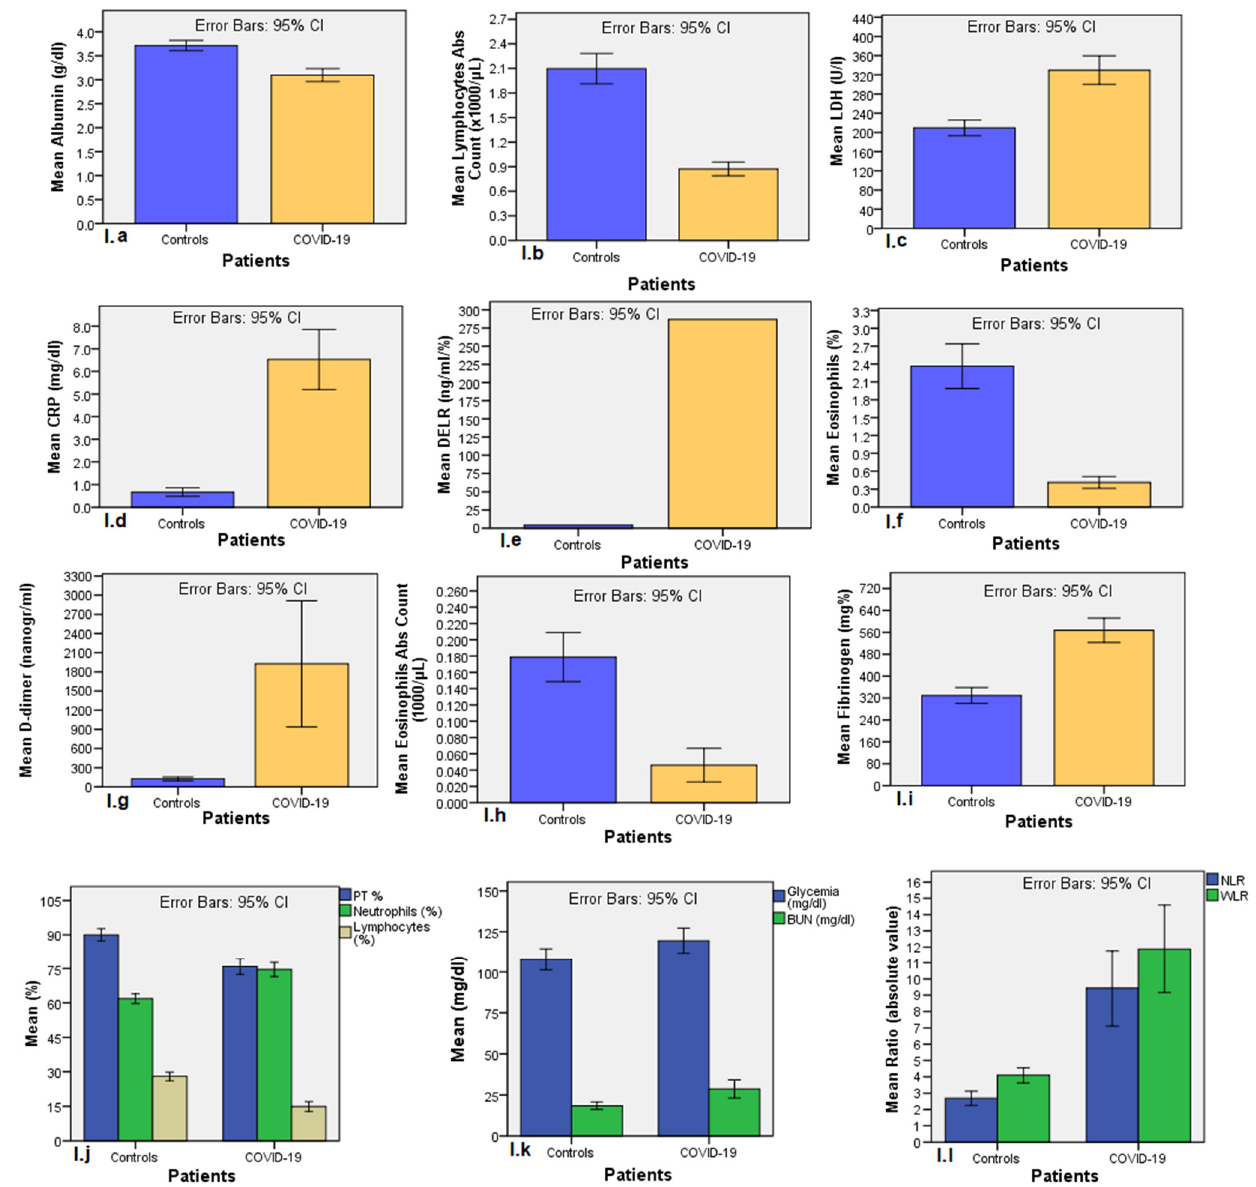
Figure 1. Bar charts comparing hematological parameters’ mean results between controls and COVID-19 patients. Bar errors are 95%CI (blood exams with the same unit of measurement and order of magnitude are shown in a single graph). ( a ) Albumin (n.v. 3.4–5 g/dl) (conversion factor (CF) for International System: ×10 (mg/L)); ( b ) Lymphocyte count (n.v. 0.9–5 × 10 3 / μ L) (CF ×1 (10 9 /L)); ( c ) LDH (n.v. 100–240 U/L) (CF: ×0.111 (mmol/L)); ( d ) CRP (n.v. 0–1 mg/dl) (CF: ×10 (mg/L); ( e ) DELR , d-dimer to the sum of percentage lymphocytes and eosinophils; ( f ) eosinophils percentage (n.v. 0–6%) %) )CF ×0.01 (fraction of 1)); ( g ) D-dimer (n.v. 0–280 ng/mL) (CF ×1 (ng/mL)); ( h ) eosinophil count. (n.v. 0–0.6 × 10 3 / μ L) (CF ×1 (10 9 /L)); ( i ) Fibrinogen (n.v. 150–400 mg/dl) (CF ×0.01 (g/dl)); ( j ) PT% (n.v. 80–120%) (CF: ×0.01 (fraction of 1)), percentage neutrophils (n.v. 40–75%) (CF ×0.01 (fraction of 1)) and percentage lymphocytes (n.v. 20–45%) (CF ×0.01 (fraction of 1)); ( k ) glucose blood levels (n.v. 74–106 mg/dl) (CF: ×0.0555 (mmol/L)) and BUN (v.n. 7–18 mg/dl) (CF: ×0.357 (mmol/L)); ( l ) NLR, neutrophils-to-lymphocytes ratio; WLR, white blood cells to lymphocytes count ratio.